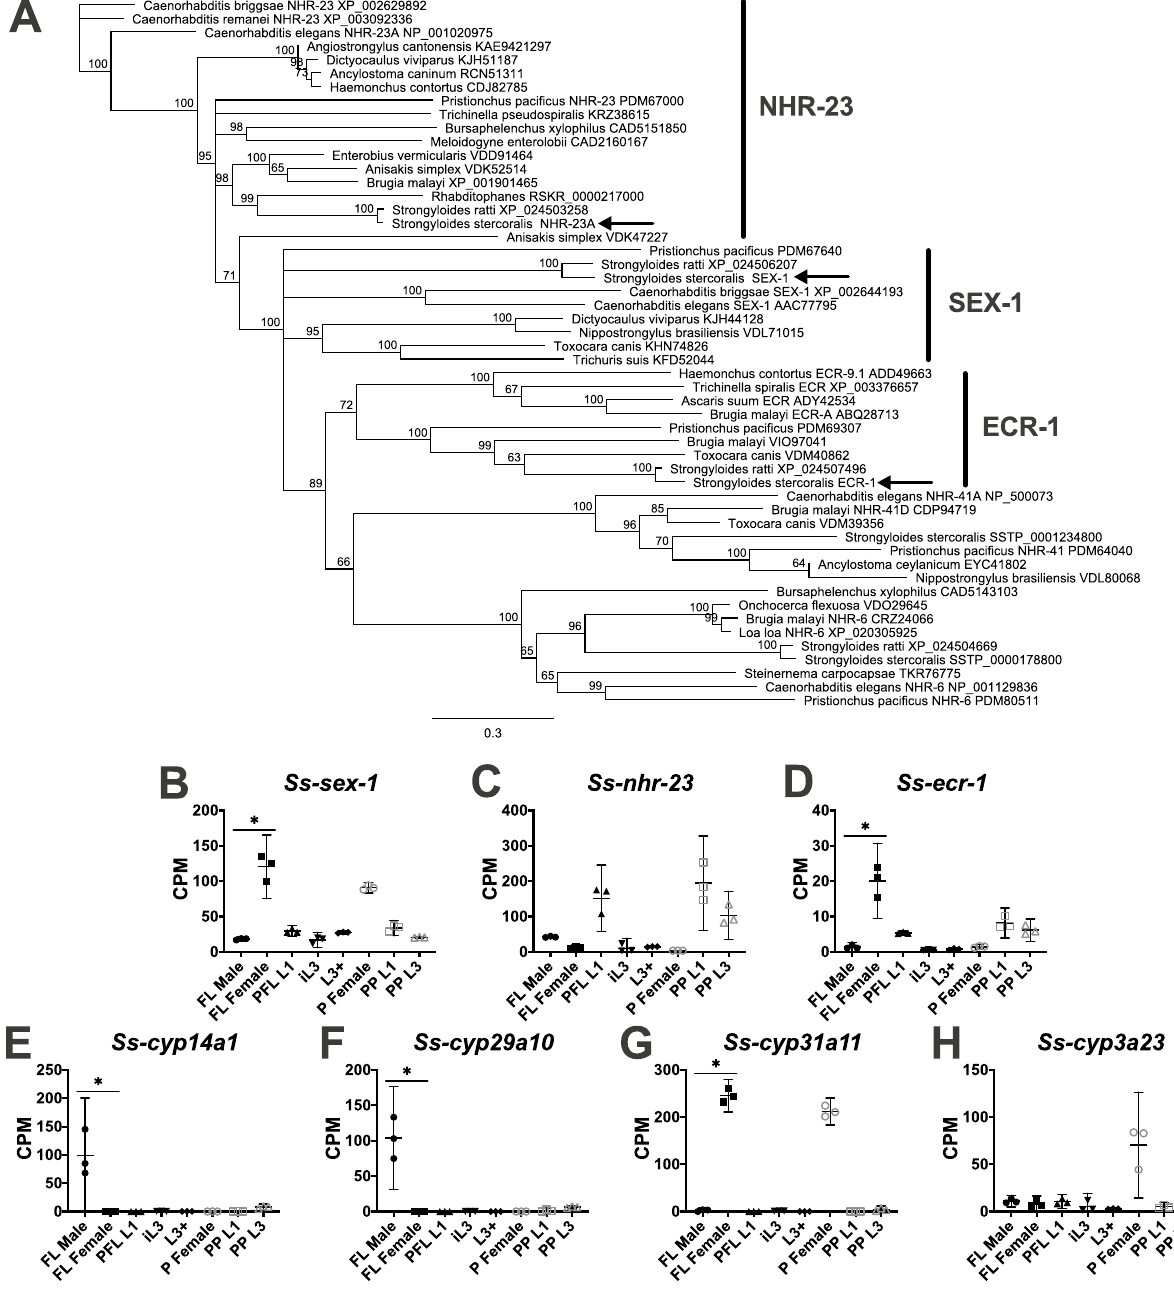
Figure 3. Transcripts encoding S. stercoralis nuclear hormone receptors and cytochrome P450s are differentially regulated between males and females. ( A ) Homologs of SEX-1, NHR-23, and ECR-1 in S. stercoralis (arrows) and other clade I, III, IV, and V nematodes are identified in a neighbor-joining phylogenetic tree with 100 iterations of bootstrapping constructed with Geneious v.11.1.5. Gene names and accession numbers are listed after the species names. ( B - H ) Transcript abundances of the S. stercoralis homologs encoding relevant nuclear hormone receptors and cytochrome P450s are represented using TMM-normalized counts per million (CPM) for the following developmental stages: free-living adult males (FL Male), free-living gravid adult females (FL Female), post-free-living first-stage larvae (PFL L1), developmentally arrested infectious third-stage larvae (iL3), L3 activated inside a permissive host (L3 +), parasitic gravid adult females (P Female), heterogonically- developing post-parasitic L1 (PP L1), and heterogonically-developing post-parasitic L3 enriched for females (PP L3). Graphs were constructed using GraphPad Prism v.9.0.0; bars indicate means (horizontal) and 95% confidence intervals (vertical) for each of the three biological replicates represented as individual data points. Asterisks (*) indicate a significant (fold change > 2.0; FDR < 0.05) difference between FL Male and FL